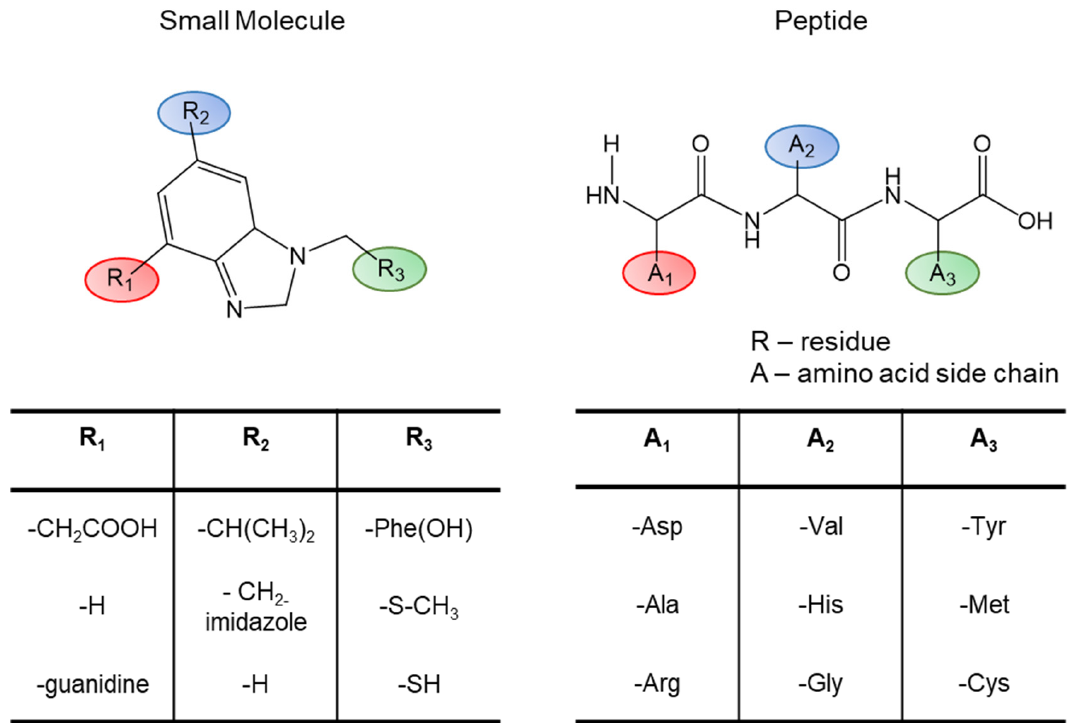
Figure 10. Schematic of peptide structure-activity relationships (SAR). In the same way as swapping chemical moieties for the small molecule (SAR). Peptide mutagenesis and alanine scanning are important tools for determining the peptide functionality at a given receptor.